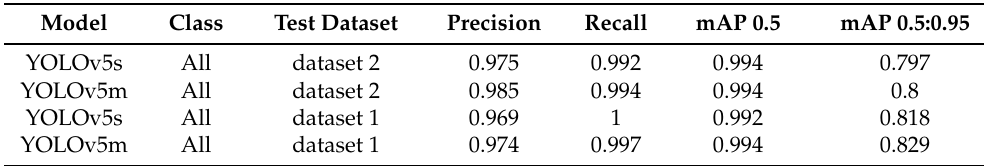
Table 6. Tests with YOLOv5s YOLOv5m for both